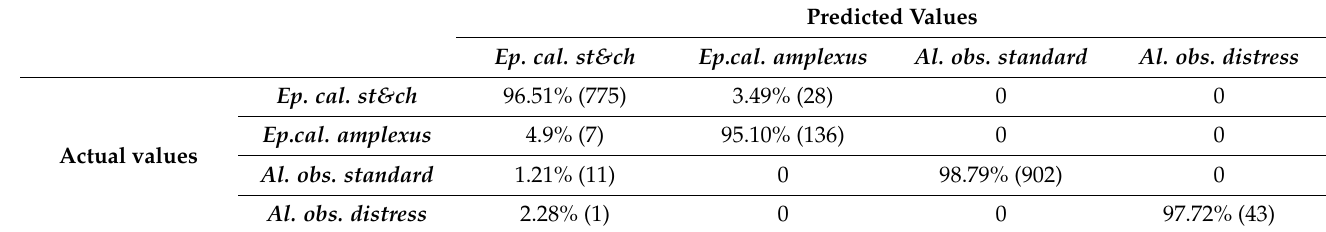
Table 2. Confusion matrix for the first CNN (4